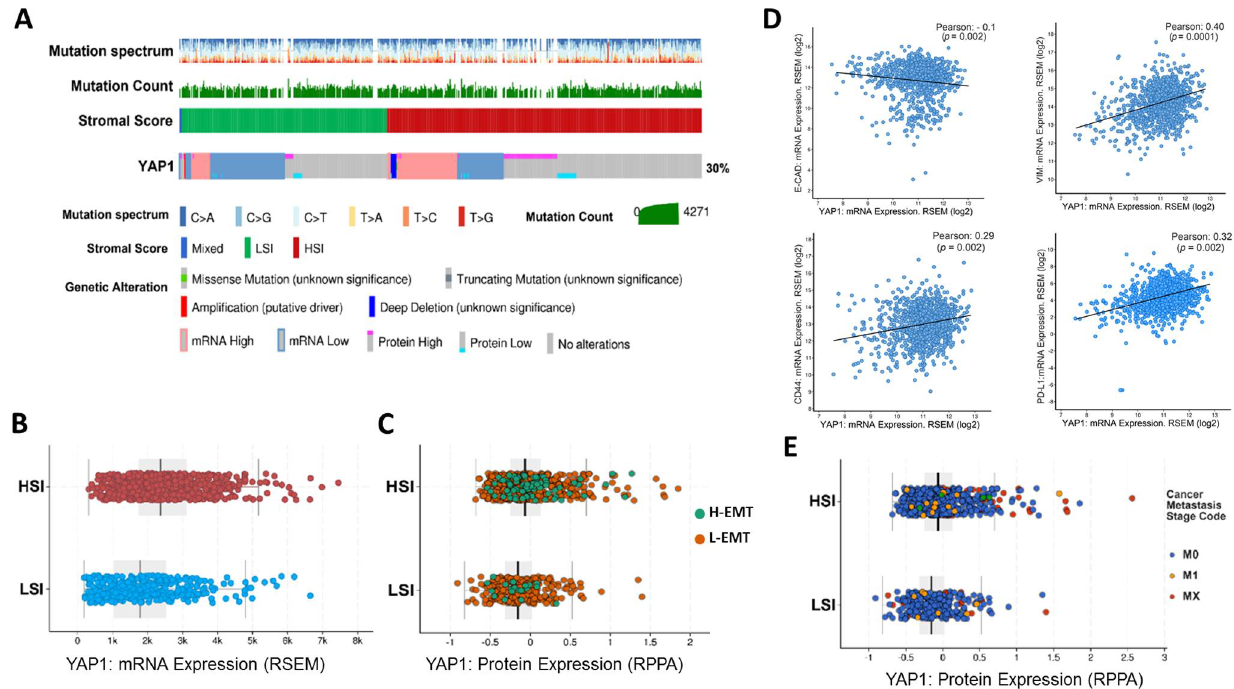
Figure 1. Genomic analysis of the TCGA breast cancer cohort. ( A ) The oncoprint illustrates YAP1 expression in two groups of samples annotated based on the stromal score signature. ( B ) Comparing the expression of YAP1 between samples with high-stromal index (HSI) and low-stromal index (LSI) indicating that samples with HSI expressed a high level of YAP1. ( C ) A High EMT status is enriched in samples with the HSI status and high level of YAP1 at the protein level. ( D ) Correlation coefficient analysis between the expression of YAP1 and classical EMT markers (VIM, CDH1), stemness marker (CD440, and immunosuppressive marker (PD-L1). The results show a negative association between YAP1 and CDH1 and a positive correlation with CD44, VIM, and PD-L1. ( E ) Association between the protein expression of YAP1 and metastatic stages in samples with a HSI and LSI score, showing enrichment of an adverse stage of metastasis in samples with high YAP1 expression and HSI score.